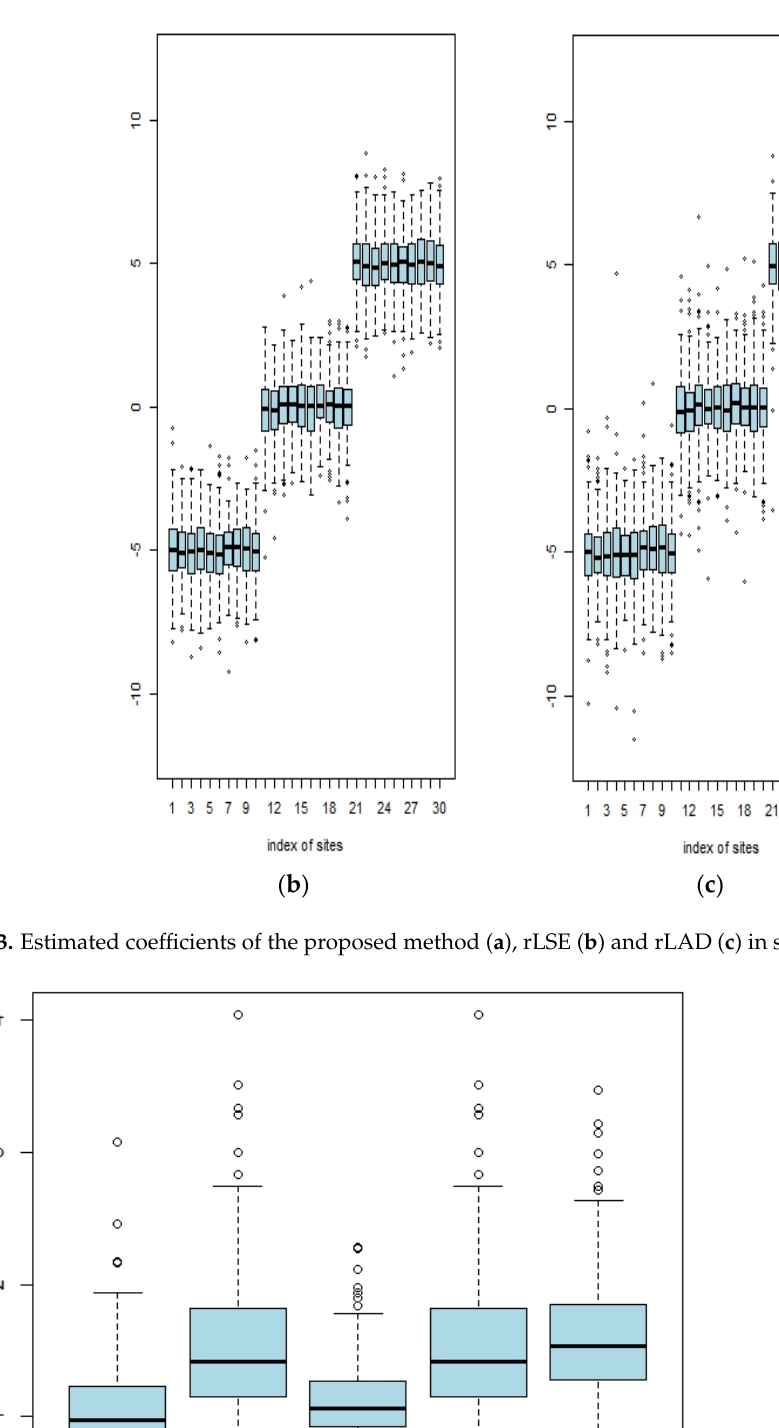
Figure 4. MSE of estimated coefficients of five methods in simulation 2. The five methods are our proposed method(proposed), the naive LSE(nLSE), the naive LAD(nLAD), the rank LSE(rLSE) and the rank LAD(rLAD).